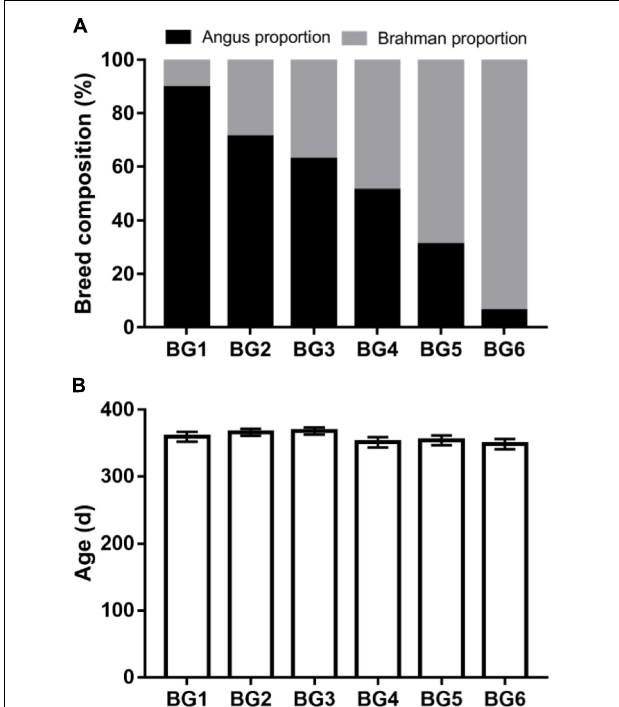
FIGURE 1 | Genetic background and age information of the multibreed Angus-Brahman multibreed (MAB) postweaning heifers. Angus and Brahman proportion of the postweaning heifers among six breed groups (BGs) (A) . Heifers were divided into six BGs based on their breed composition. The breed composition of BG1 to BG6 ranged from 100% Angus to 100% Brahman. The age of postweaning heifers among six BGs (B) . n BG1 =